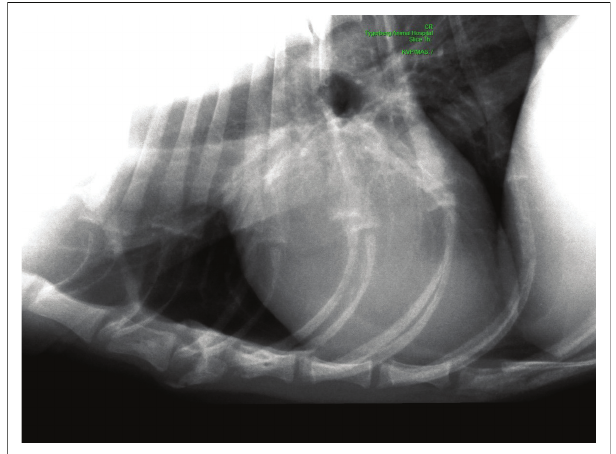
FIGURE 2: Radiographic lesion of the sternebrae (left lateral thoracic